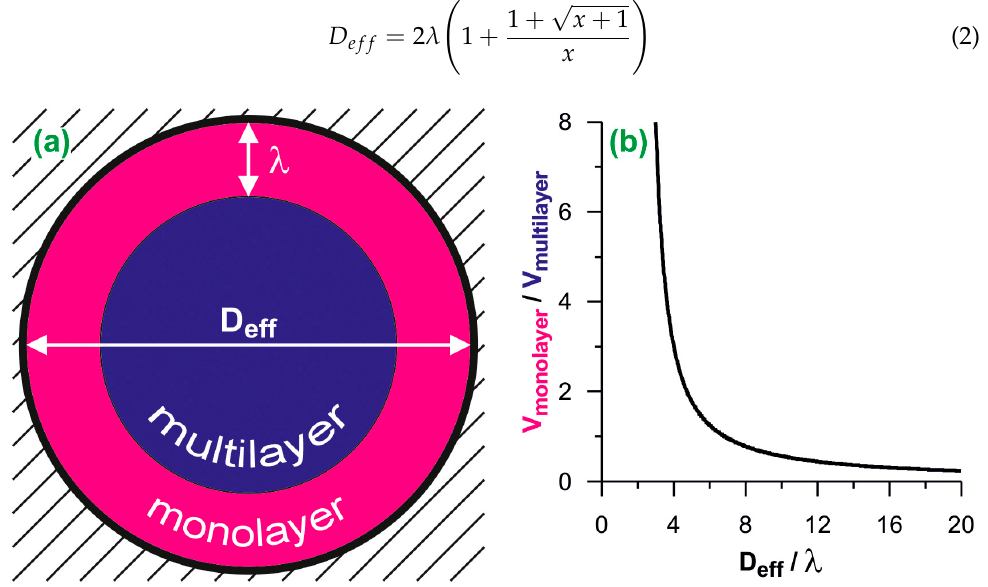
Figure 1. ( a ) The scheme of the division of cylindrical adsorption space into the monolayer and the multilayer. D eff is the effective diameter and λ is the monolayer thickness; ( b ) the ratio of monolayer and multilayer volumes plotted as the function of the effective diameter. The diameters are reduced by the monolayer thickness.